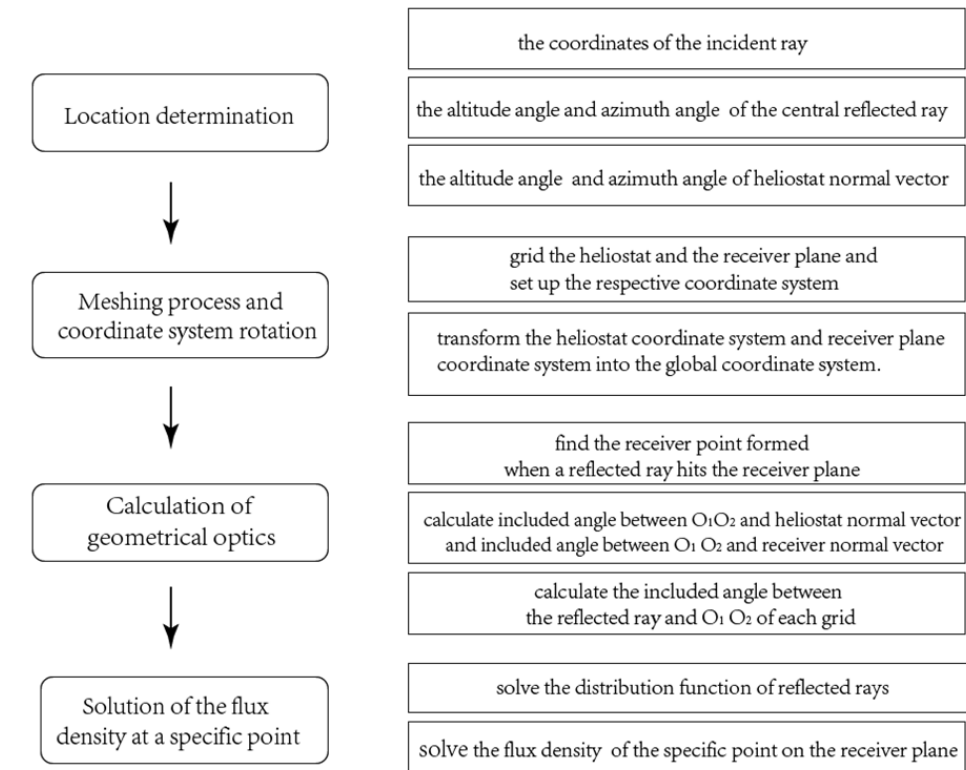
Figure 4. Solution of the flux density at a specific point.